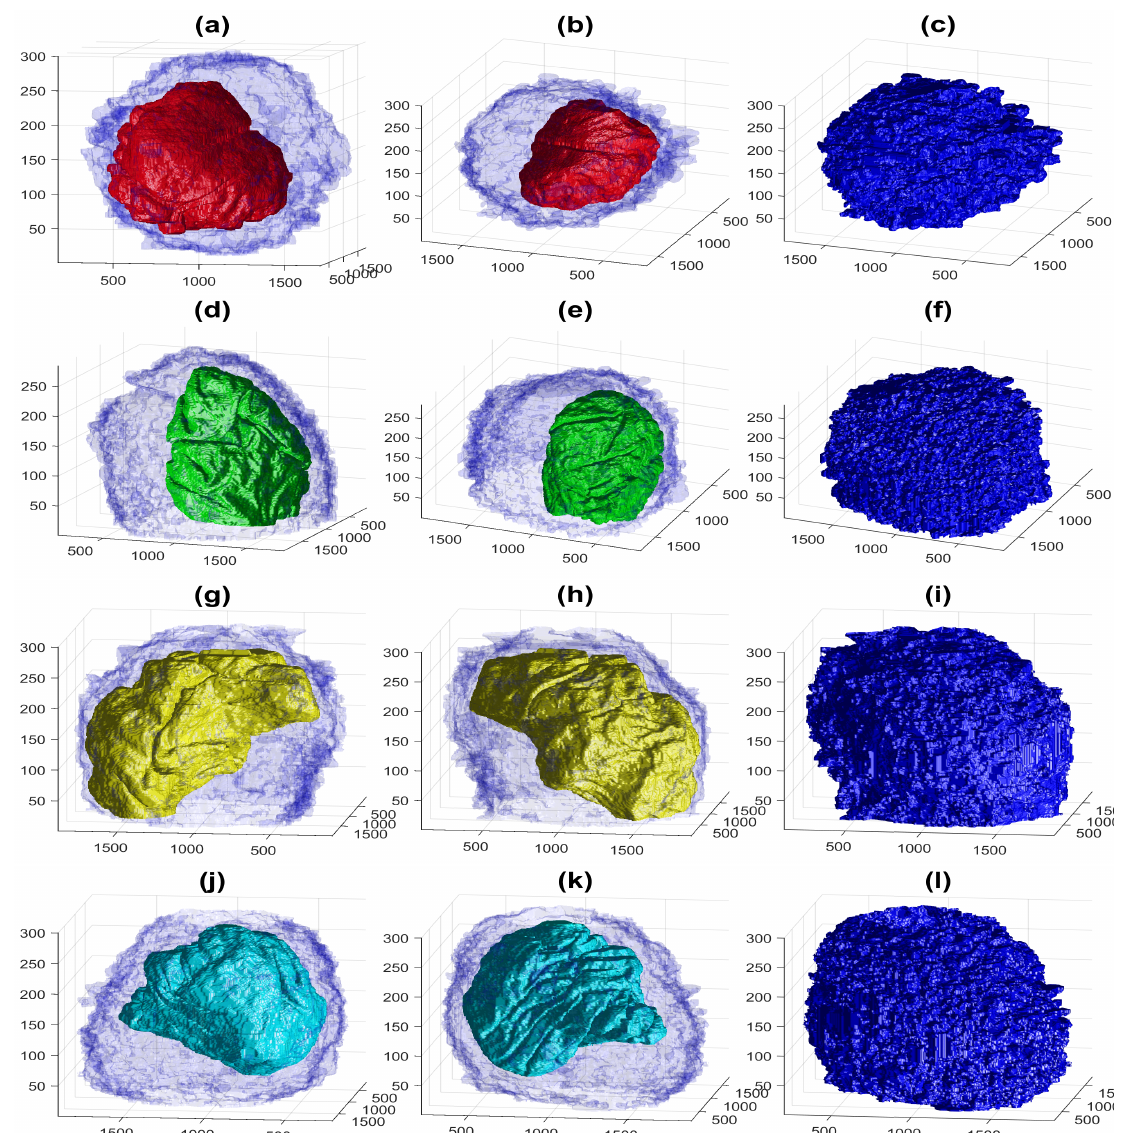
Figure 9. Four examples of the volumetric reconstruction of the NEs and the cell membranes of HeLa cells. In all cases, each row corresponds to a single cell observed from different view points. The left and centre columns show the cell membrane as transparent. The right column is the cell membrane without transparency from the same view point as the centre column. The volume of interest is 2000 × 2000 × 300 voxels, and the units of the axes are in voxels. ( a – c ) ROI 23; the NE is shown in red and the cell in blue. Notice the relative smoothness except for one groove along the cell and the concentration on the lower part of the cell. ( d – f ) ROI 3; the NE is shown in green. Notice the ruggedness of the NE with numerous grooves and the concentration of the nucleus towards one side of the cell. ( g – i ) ROI 12; NE is shown in yellow. Notice the distribution of the nucleus concentrated on the upper part of the cell. ( j – l ) ROI 19; NE is shown in cyan. The surface of the NEs appears more distinctive than those of the